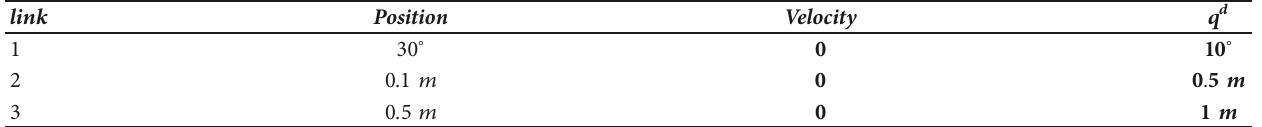
Table 4: The initial conditions of the location and velocity and the desired values (q d ) of each of the links. 𝑙𝑖𝑛𝑘